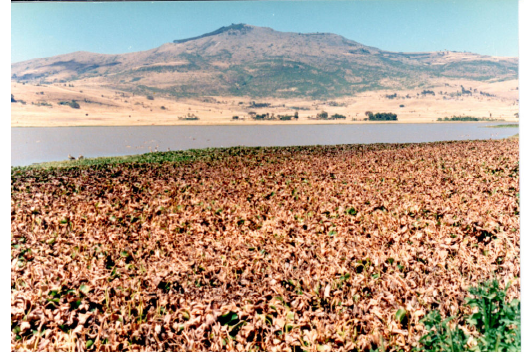
Figure 3. Water lily on the surfaces of the lake in June 1989